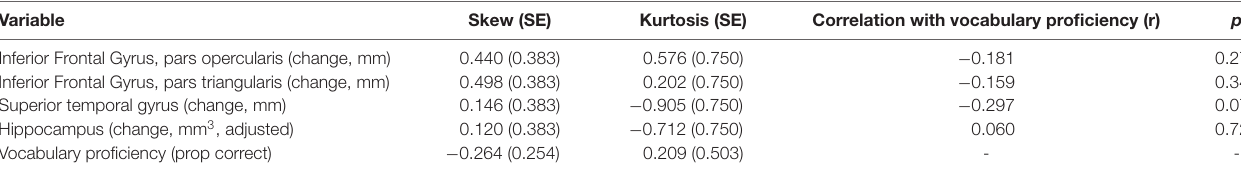
TABLE 3 | Relationship between achieved vocabulary proficiency and change in gray matter regions of interest. Variable